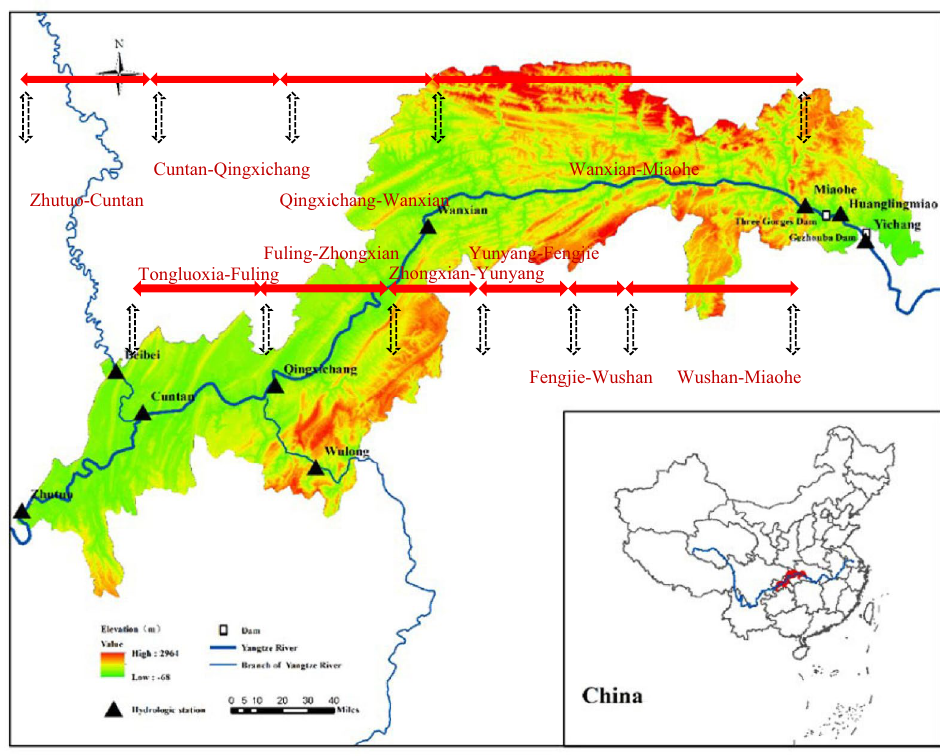
Figure 1. Sketch map of the TGR